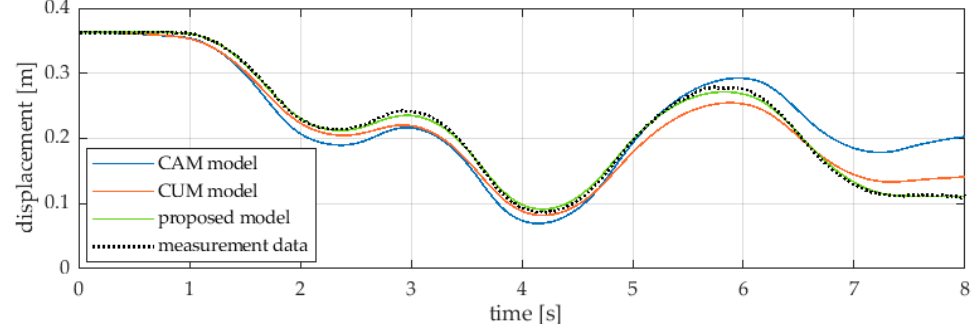
Figure 5. Ball displacement as a function of time and comparison of waveforms from experimental data and numerical models.